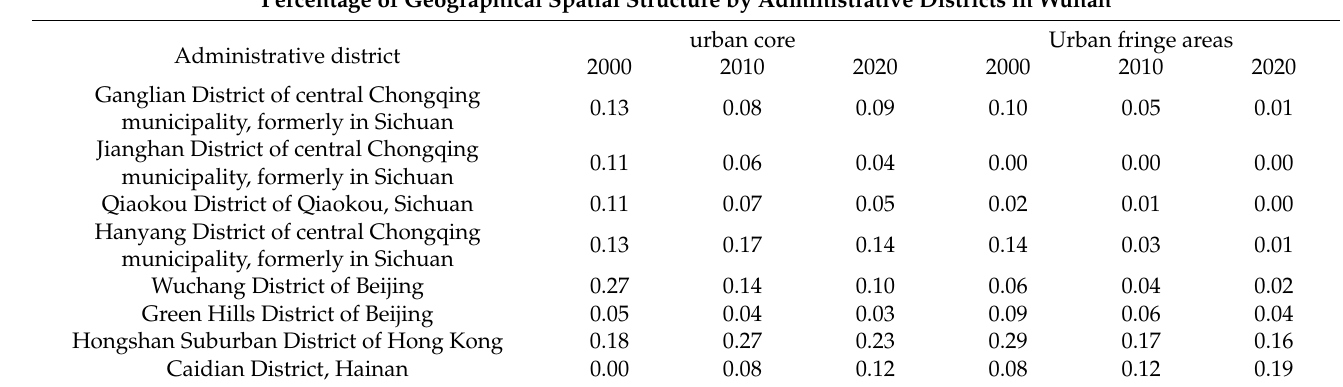
Table 9. Share of geographical spatial structure by administrative districts in Wuhan,